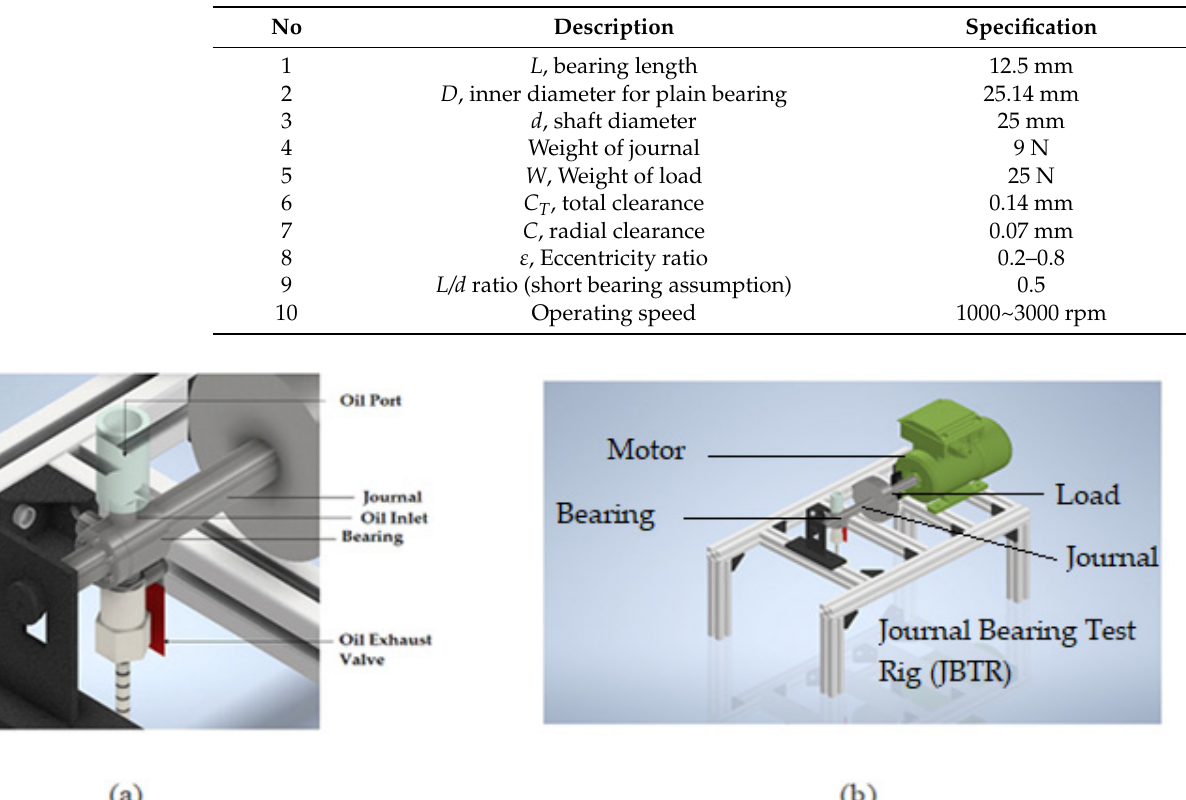
Table 1. Specifications of the Journal Bearing Test Rig (JBTR).